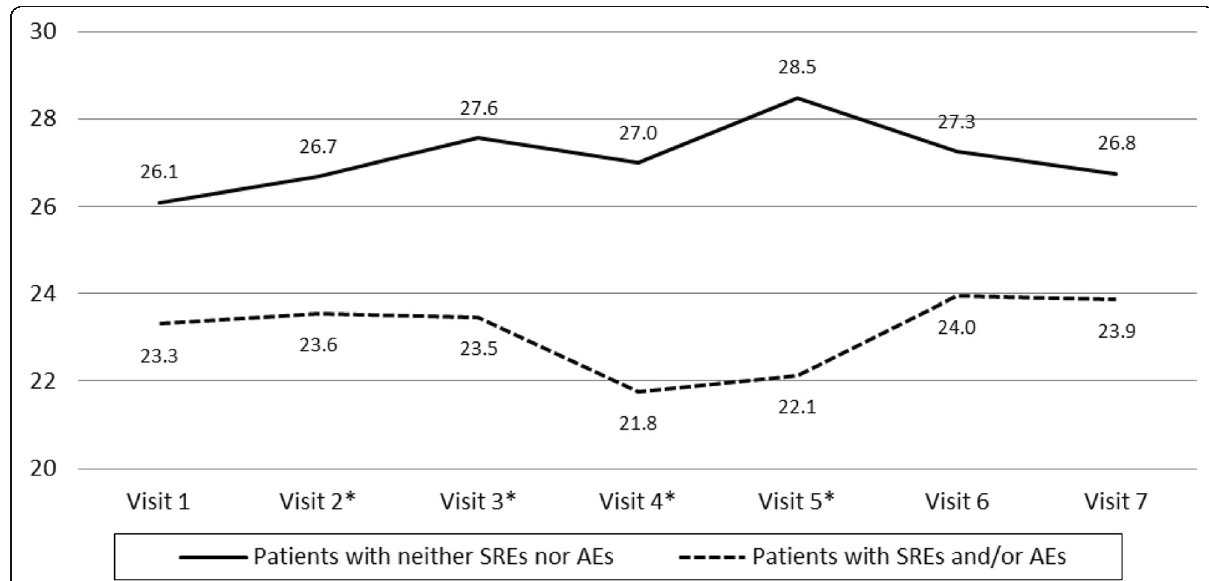
Fig. 2 BOMET-QoL-10 mean scores for each visit over time reported by patients with AEs and/or SREs versus patients with neither. Higher scores indicate better Health Related Quality of Life.*Mean scores are statistically different between patient groups ( p <